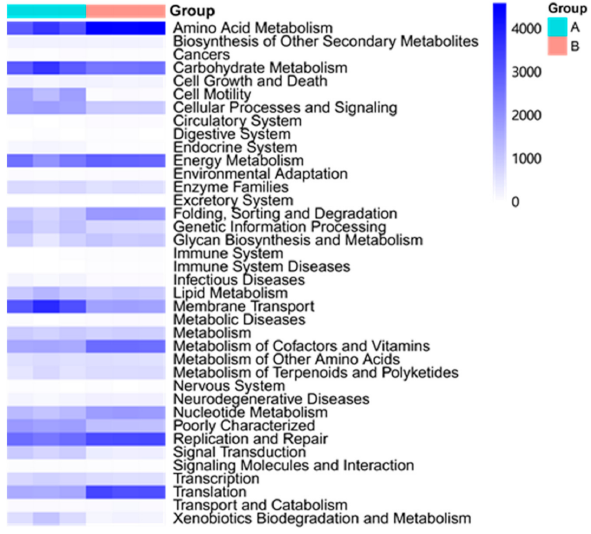
Figure 8. The heatmap of KO groups predicted by PICRUSt analysis in G. haimaensis (Group A) and A. marissinica (Group B) at KEGG level